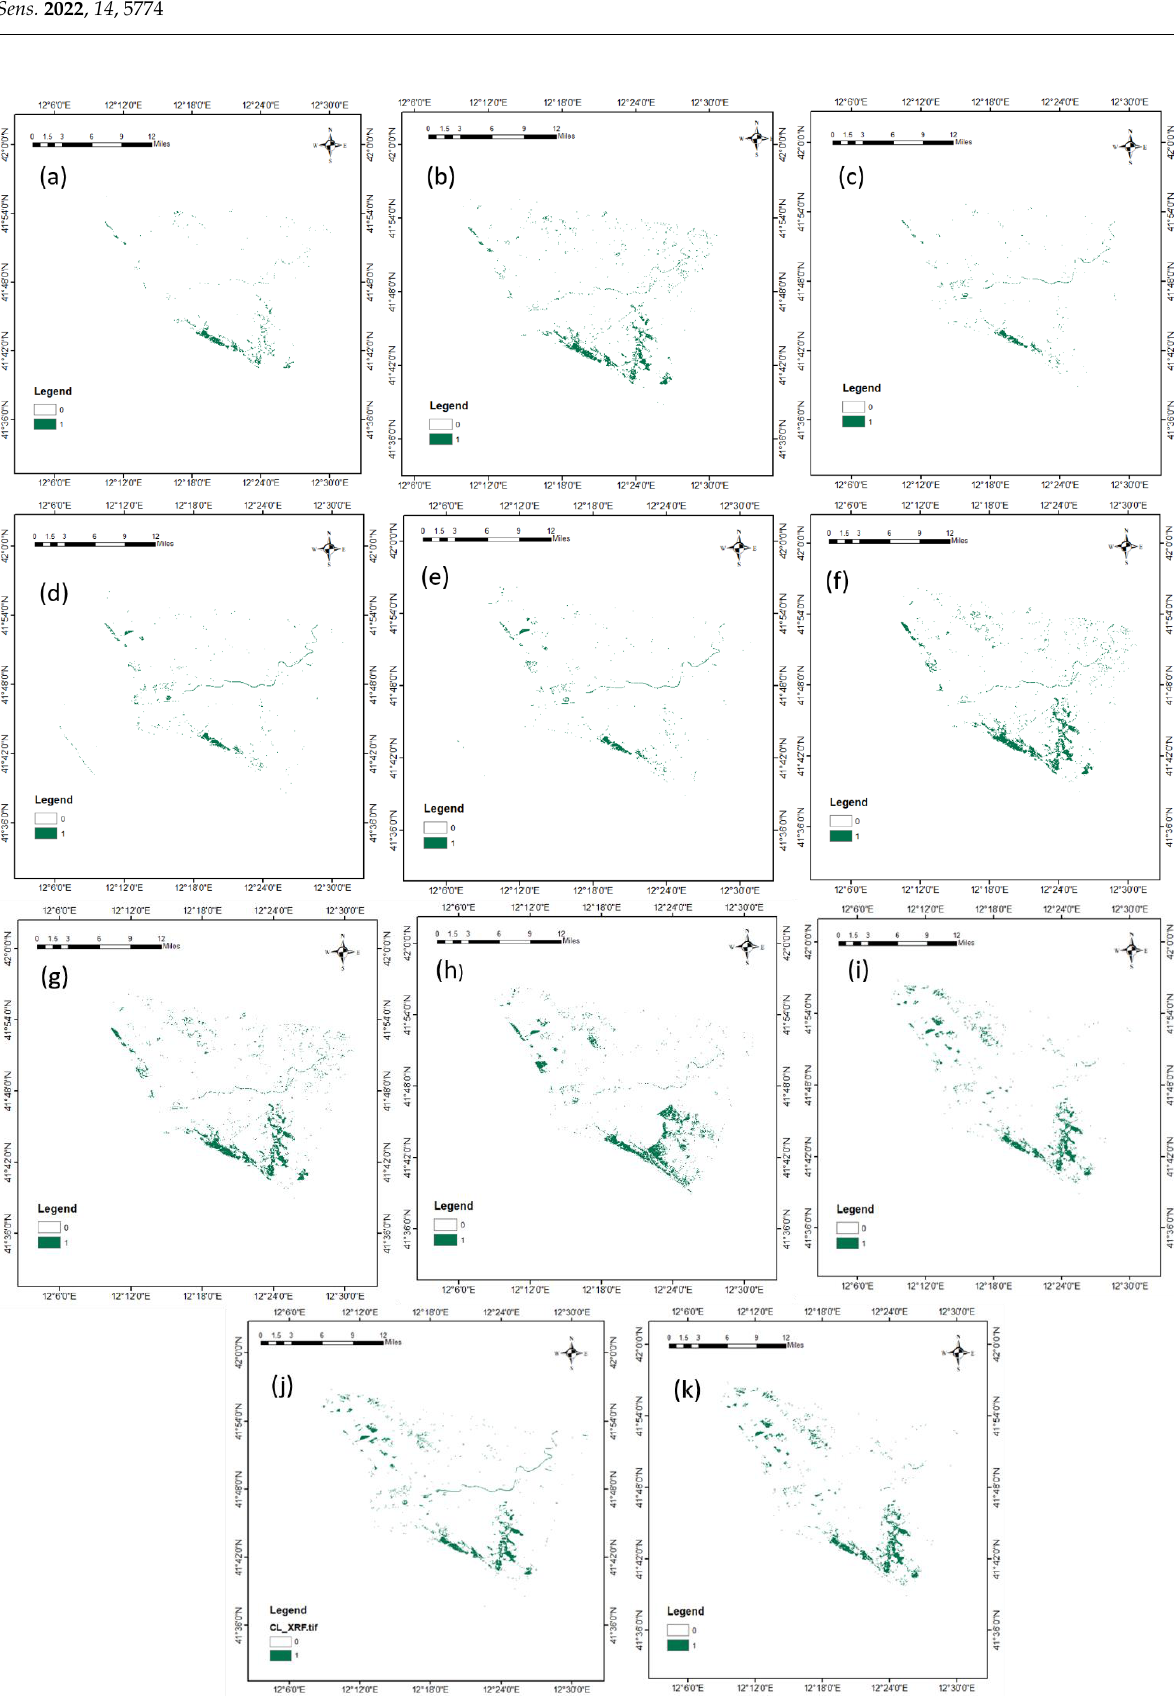
Figure 4. Classification of pine trees using ( a ) SVM, ( b ) KNN, ( c ) Random Forest, ( d ) LGBM, ( e ) XGBoost, ( f ) SVC + Decision Tree, ( g ) Random Forest + SVC, ( h ) Random Forest + Decision Tree, ( i ) XGBoost + Decision Tree, ( j ) XGBoost + Random Forest, and ( k ) XGBoost + SVC.